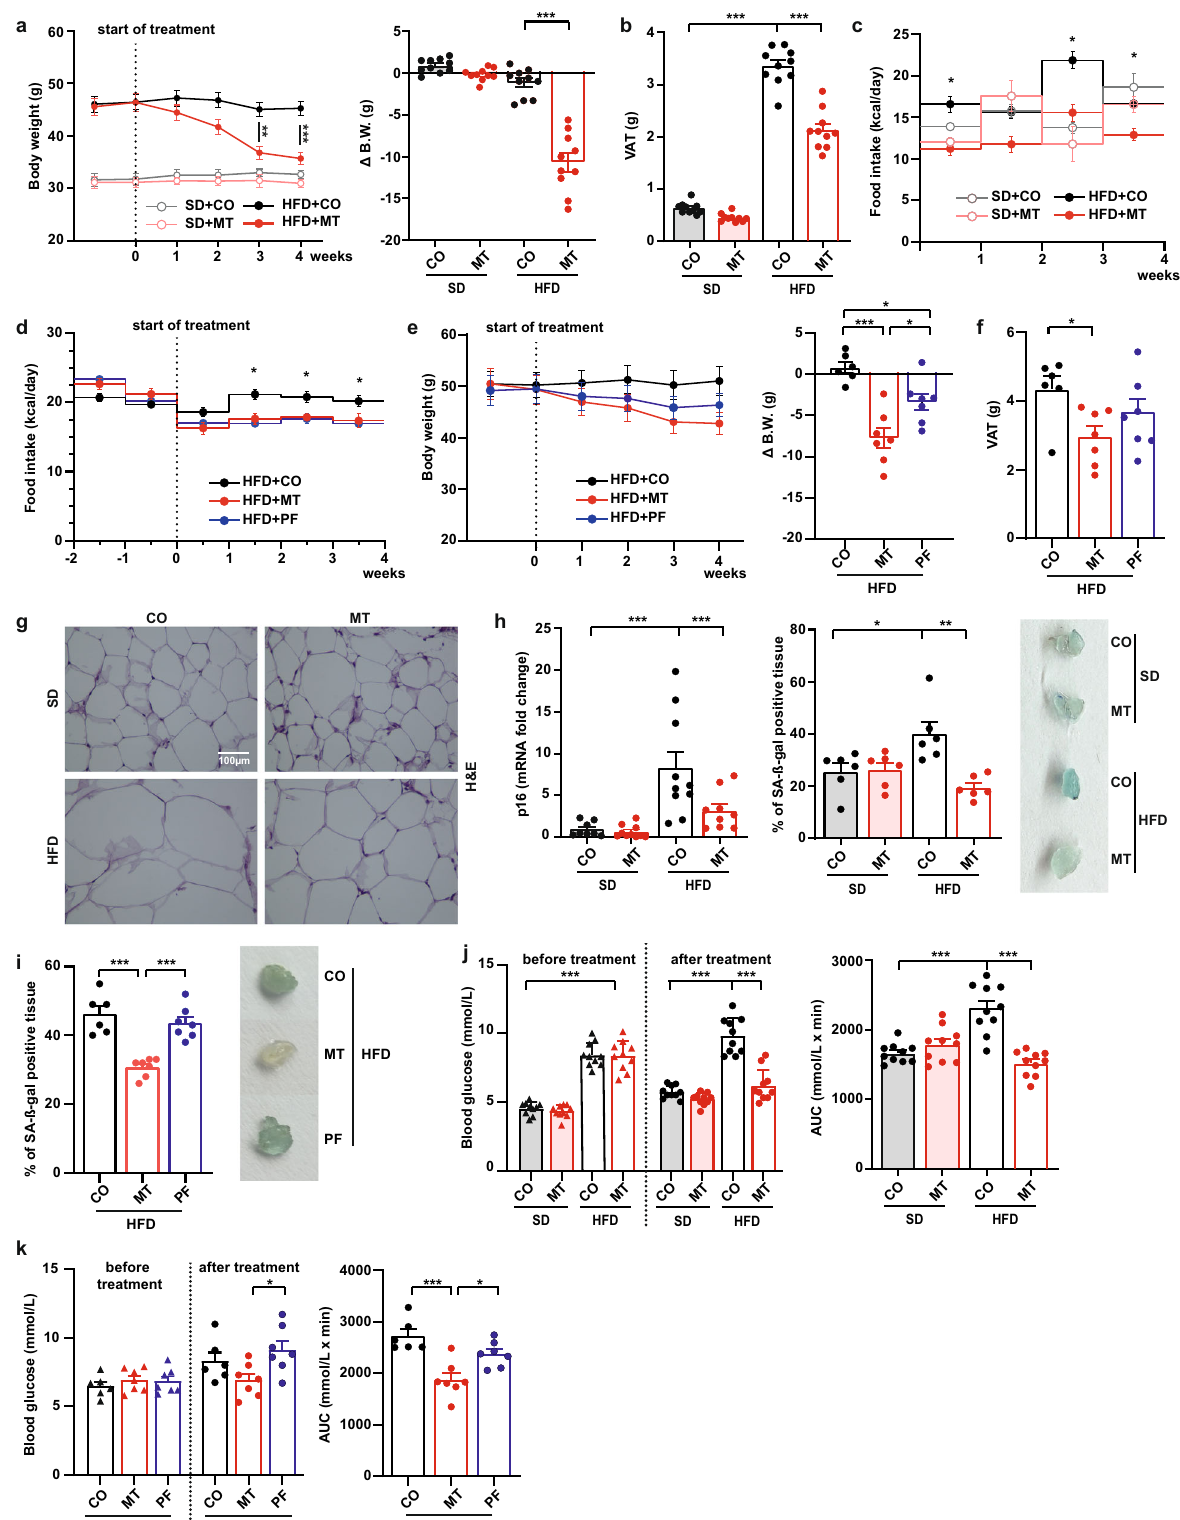
Fig. 2g). Lowering of fasting blood glucose and oGTT improve- ment levels were not observed in PF mice (Fig. 2k, Supplementary Fig. 2h). The D -glucose levels in feces did not differ between MitoTam-treated and control mice (Supplementary Fig. 2i; mice fed ad libitum were used as a control) arguing against the role of impairment of intestinal glucose uptake in MitoTam ’